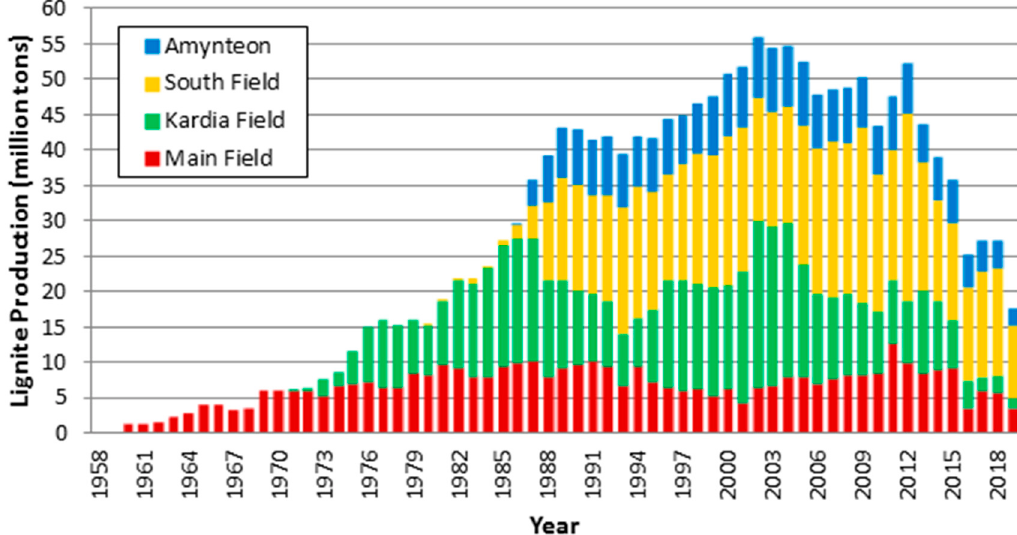
Figure 1. Lignite production of the western Macedonia Lignite Centre [12].